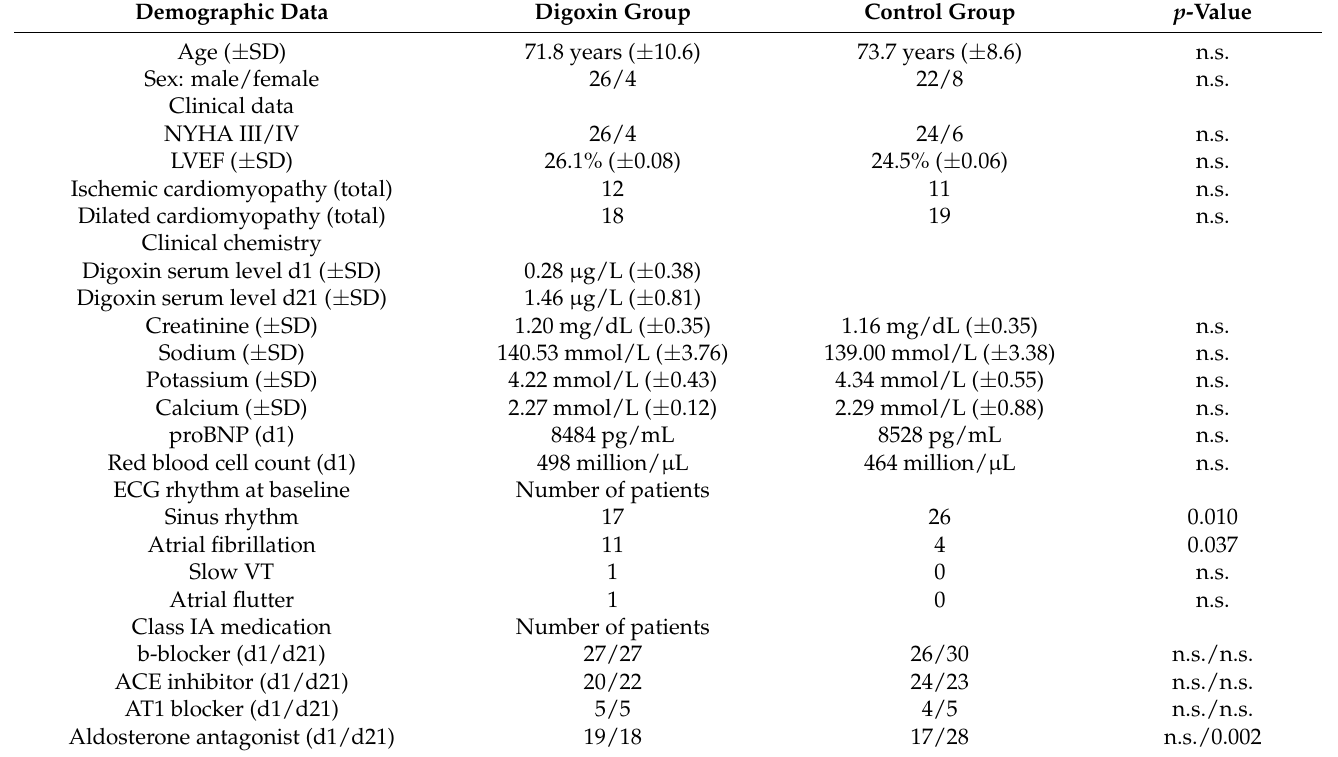
Table 1. Baseline data and OMT prescribed